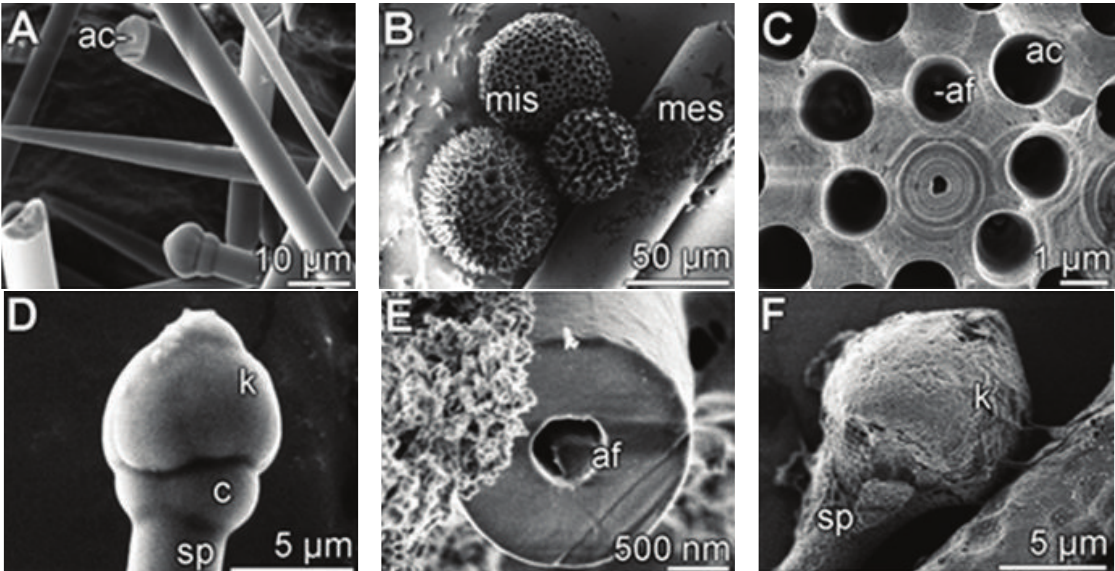
(ac) visible where <